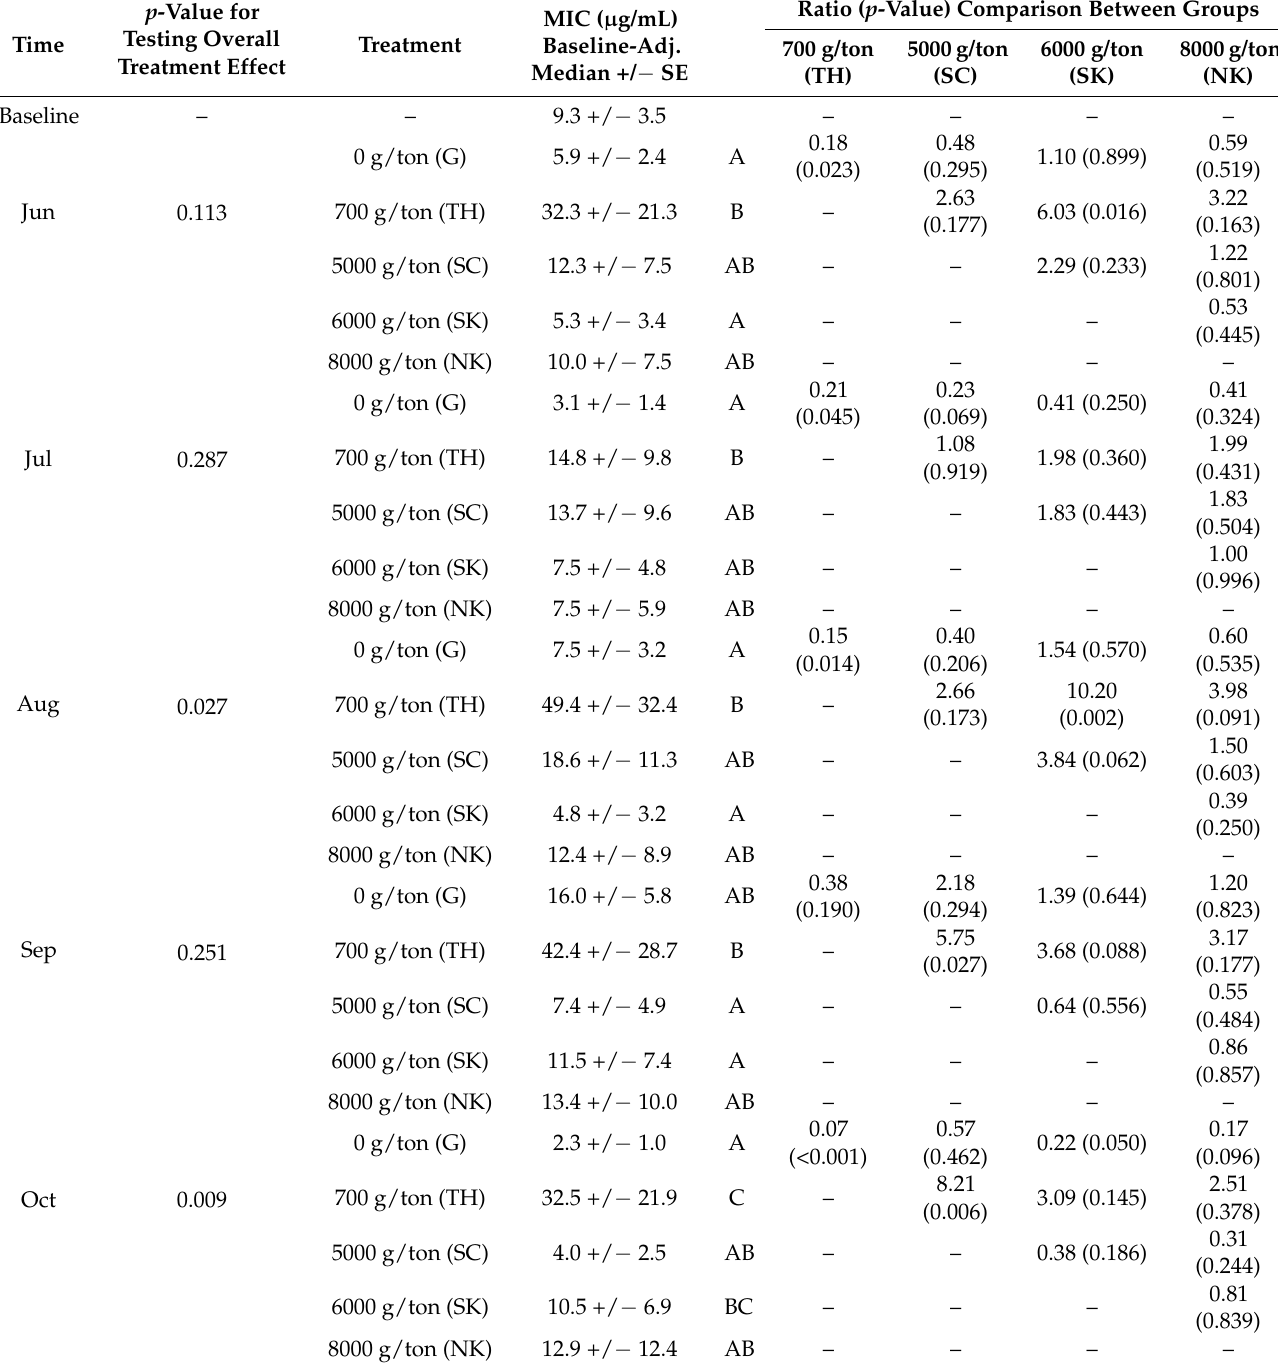
Table 3. Within-time comparison of median MIC values in treatment groups of pastured cattle provided four different FDA-approved formulations of CTC-medicated mineral throughout five months of continuous CTC treatment. Treatment groups with the same letter were not significantly different in their pairwise